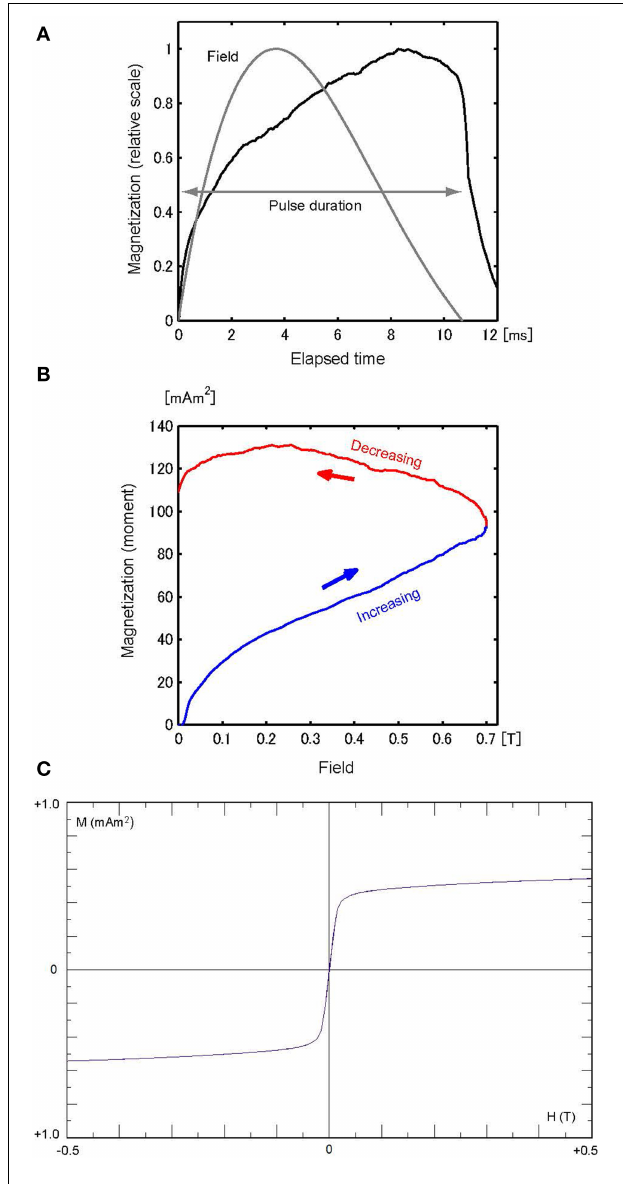
magnetization (131mAm 2 ), with the H-t curve (gray) scaled to 0.7 T. (B) M–H curve for the increasing field (blue) and reducing field (red). (C) Hysteresis loop of PL